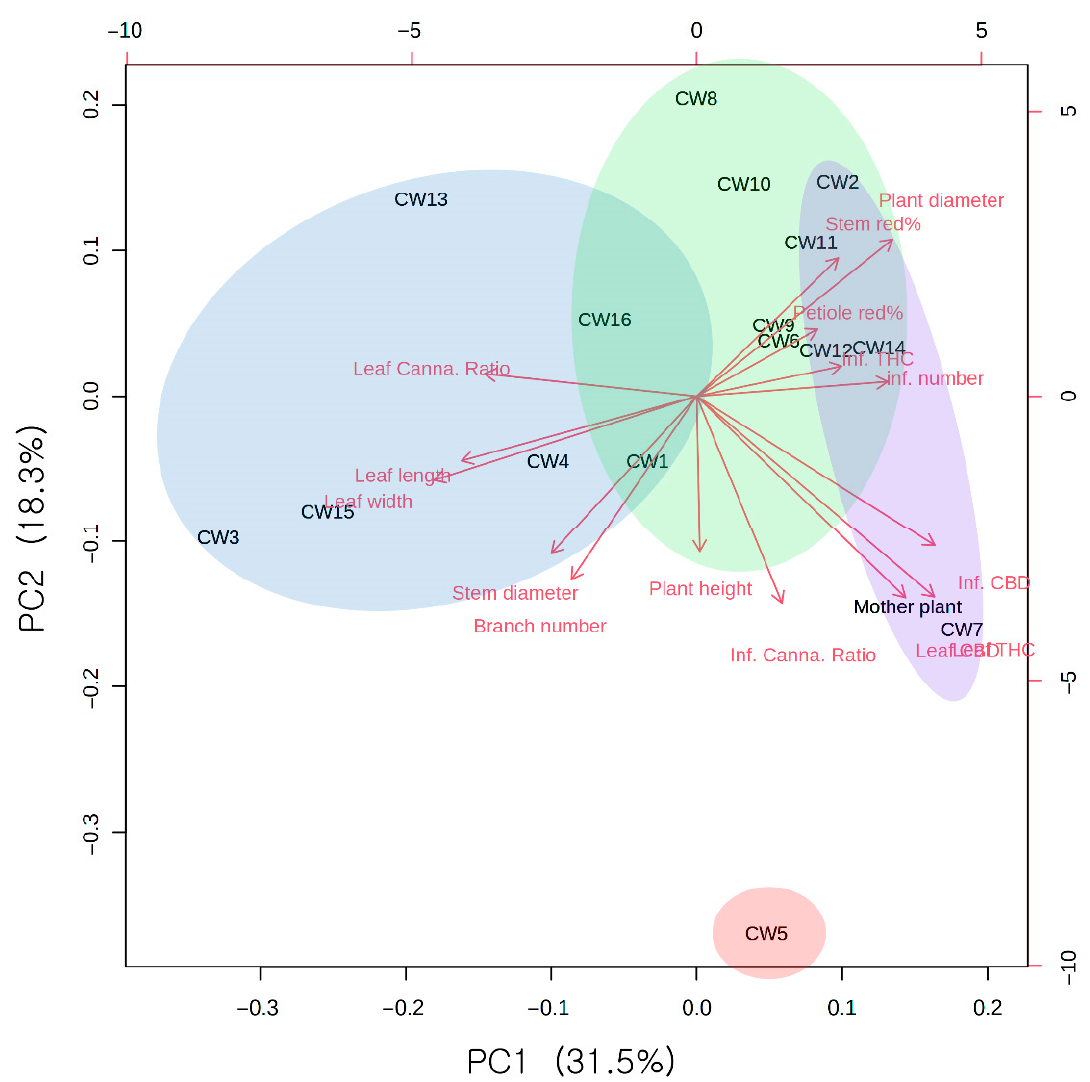
Figure 6. Principal Component Analysis (PCA). All cannabinoids included acidic precursors. Three types of clusters were presented through the Self-Organizing Map (SOM), which were grouped based on morphology and cannabinoid. In PCA, the lines starting from the central point of the biplots display negative or positive associations of different variables, and their proximity specifies the degree of correlation with specific treatment.